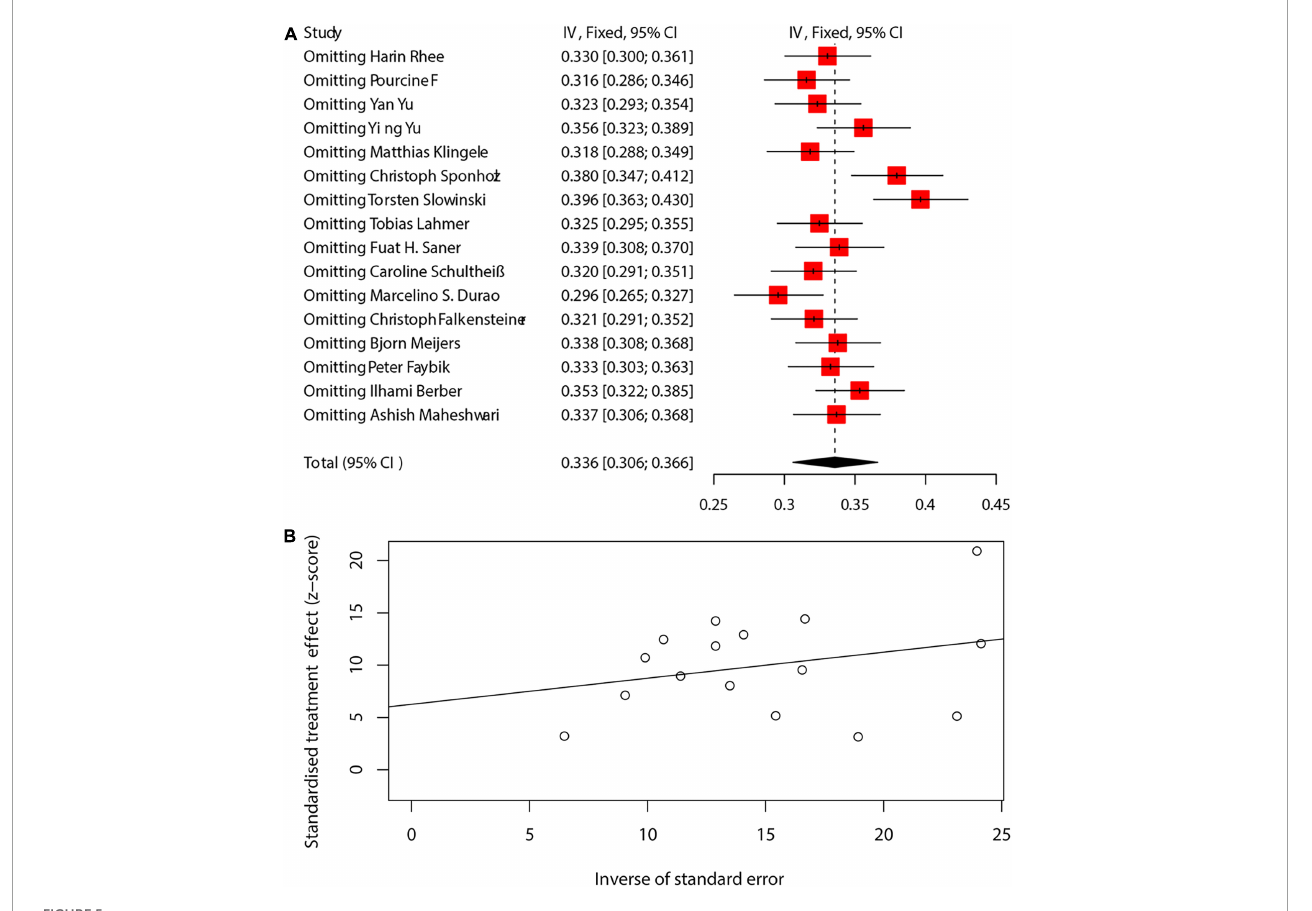
FIGURE5 The sensitivity and publication bias of the main results of mortality (A,B) . CI, confidence